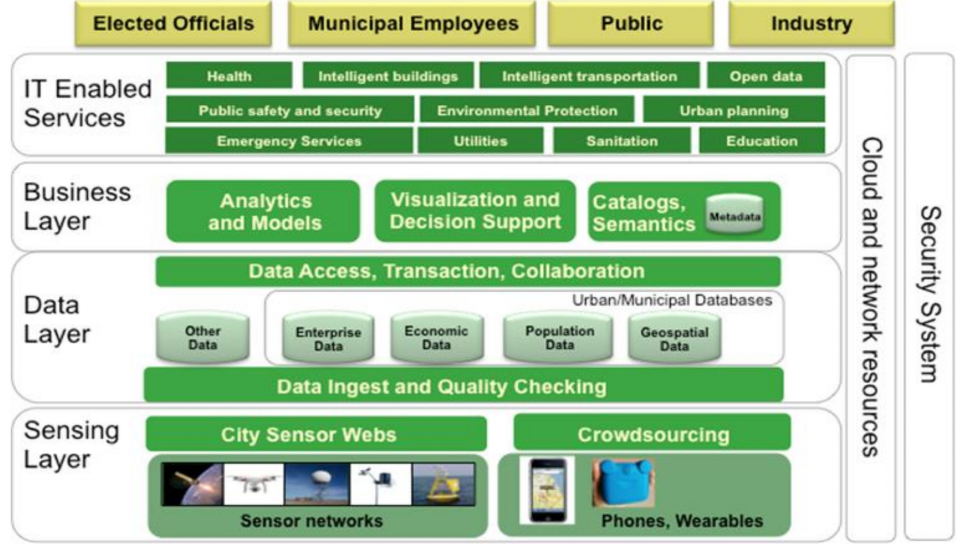
Figure 2. ESPRESSO project reference